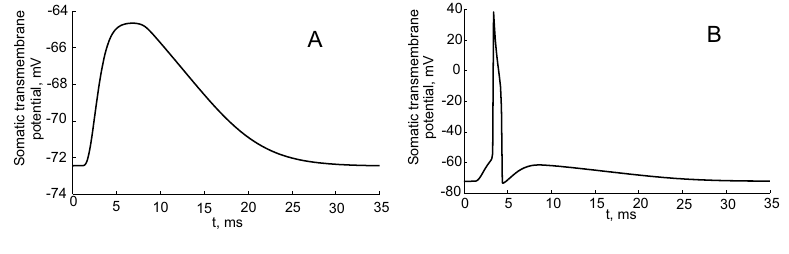
Figure 4. Simulation of the somatic transmembrane potential ( ϕ 1 - ϕ 0 ). A – g AMPA = 40 mS, g NT = 60 µ M, B – g AMPA = 180 mS, g NT = 60 µ M.